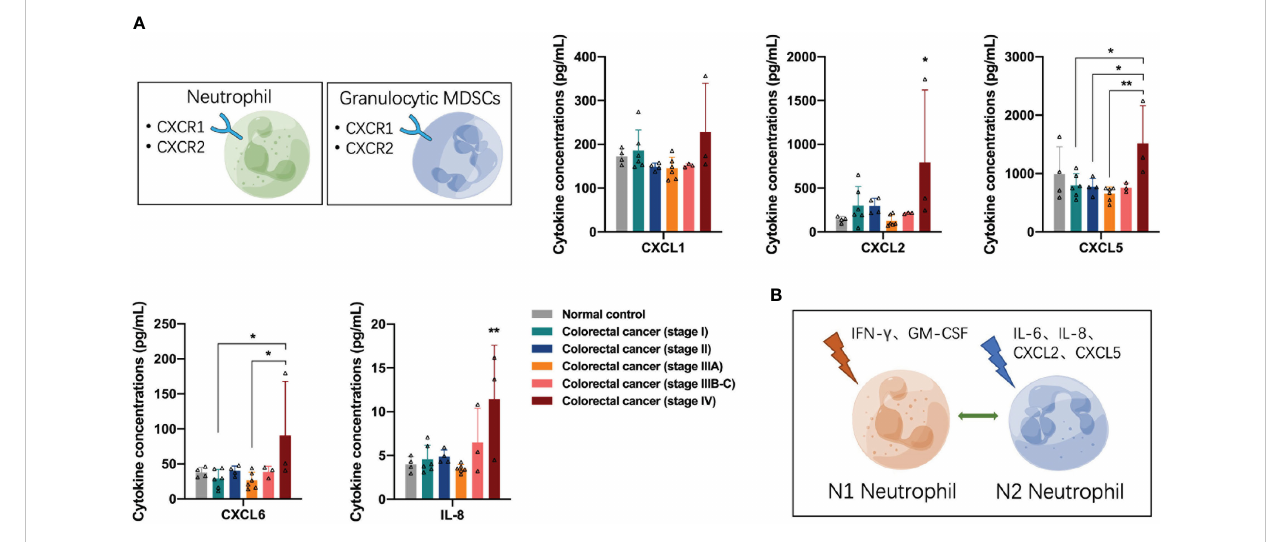
FIGURE 3 Distribution of neutrophil/granulocyte-myeloid-derived suppressor cell-associated cytokines in the peripheral blood of the participants. (A) The concentrations of CXCR1/2 ligands CXCL2, CXCL5, CXCL6, and IL-8 were signi fi cantly increased in the peripheral blood of patients with stage IV colorectal cancer. (B) Neutrophils undergo N1 or N2 polarization in response to stimulation by different cytokines in the tumor microenvironment.